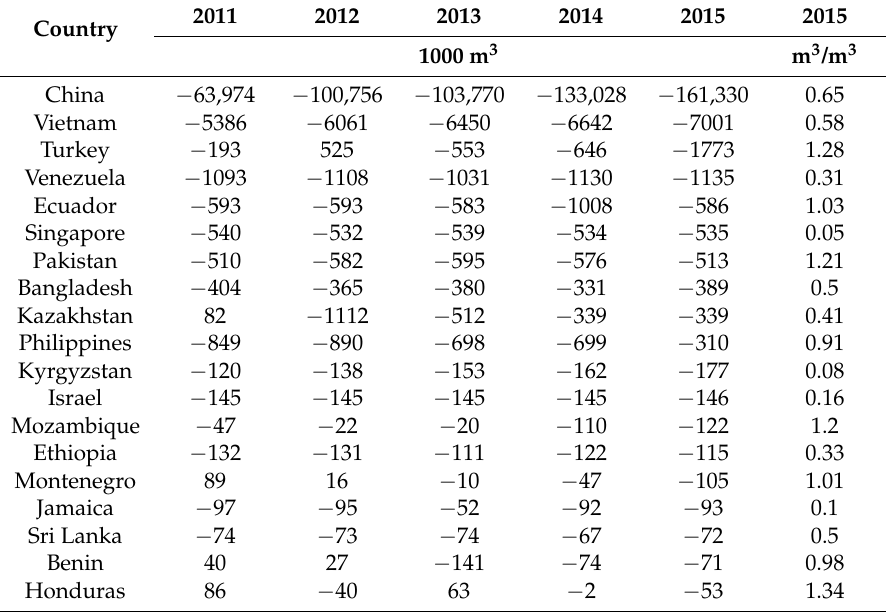
Table 5. Results from test iii for sawlogs and veneer logs. a deficit in a country is defined as “domestic harvests + imports of any industrial roundwood − minimum wood input required in production of sawnwood, plywood, and veneer” during 2011–2015, and the maximum log input coefficient in the solid wood production in 2015 is defined as “(domestic harvests of sawlogs and veneer logs + imports of any industrial roundwood)/(production of sawnwood, plywood and veneer)”. Only countries that had a deficit of more than 50,000 m 3 in 2015 are